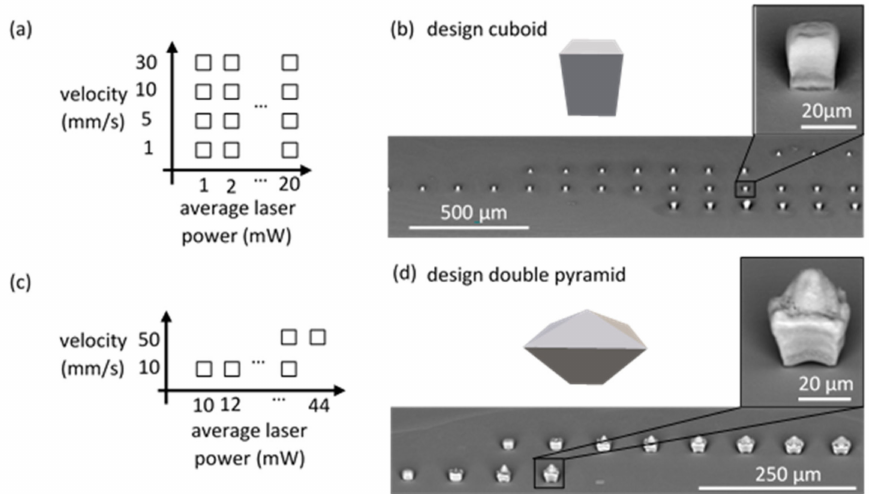
Figure 2. Parameter field for cuboid structures (20 µ m × 20 µ m × 30 µ m). ( a ) Layout (not to scale) and ( b ) overview SEM image with the respective designs. Parameter field for double pyramid structure: ( c ) layout (not to scale) and ( d ) overview SEM image of the structures that remained on the substrate’s surface after the development step. Both overview SEM images feature a magnified image of one exemplary